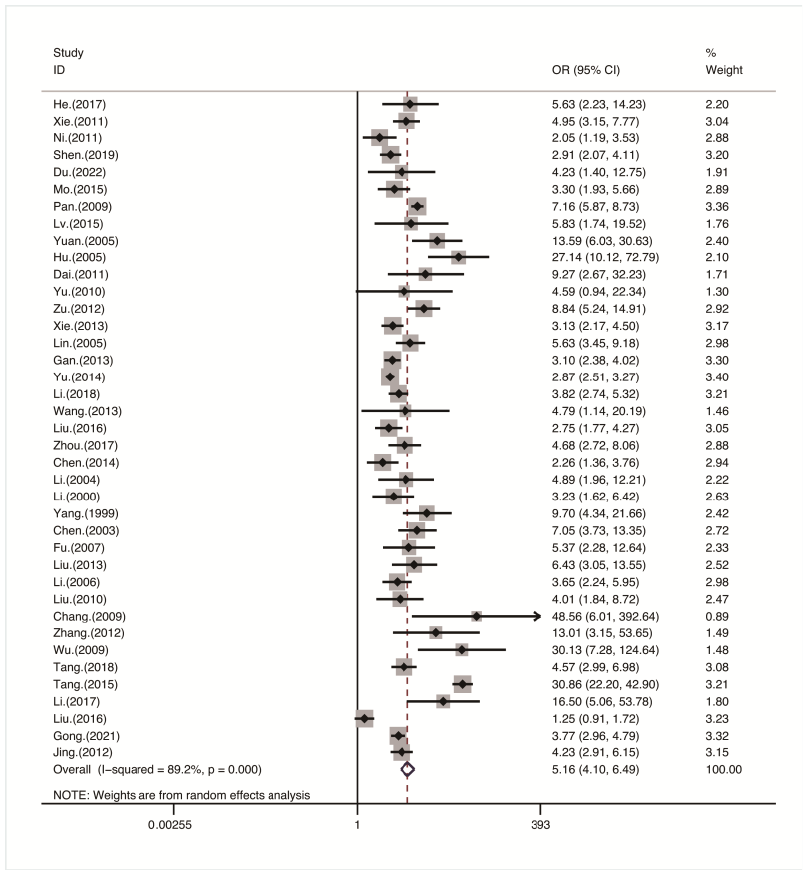
Figure 2. Forest plot of noise exposure and HFNIHL risk [14 – 52]. Table 2. Characteristics of the noise exposed group compared to the control